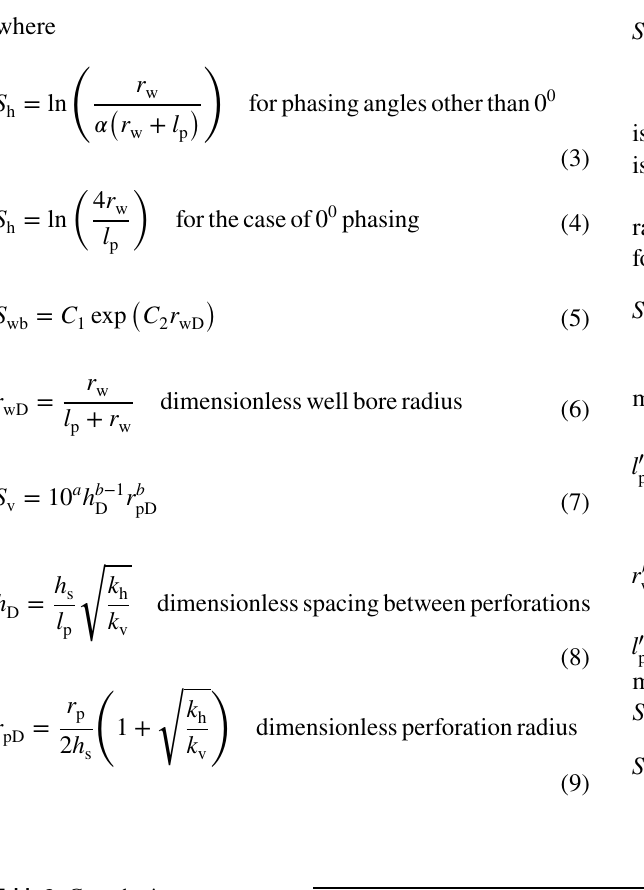
Table 2 Gun-phasing parameters for Karakas and Tariq perforation model (Bellarby